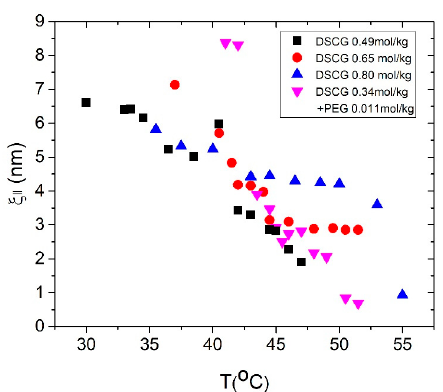
Figure 7. Temperature dependence of the positional correlation length ξ (cid:107) for DSCG 0.34 mol/kg + PEG 0.011 mol/kg (magenta triangle base-up), DSCG 0.49 mol/kg (black square), DSCG 0.65 mol/kg (red circle), and DSCG 0.80 mol/kg (blue triangle base-down).